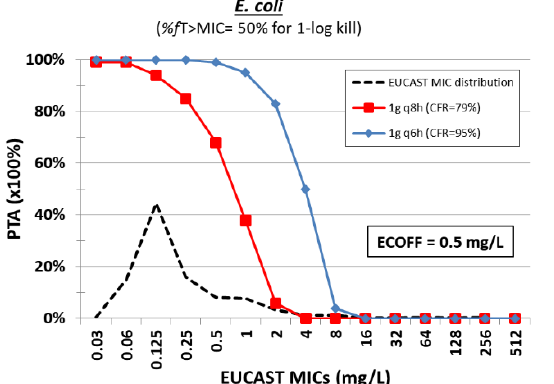
Figure 5. Probability of target attainment (PTA) of mecillinam at different dosing regimens against isolates with increasing MIC. The cumulative fraction of response (CFR) is shown for a collection of isolates with the EUCAST MIC distribution.